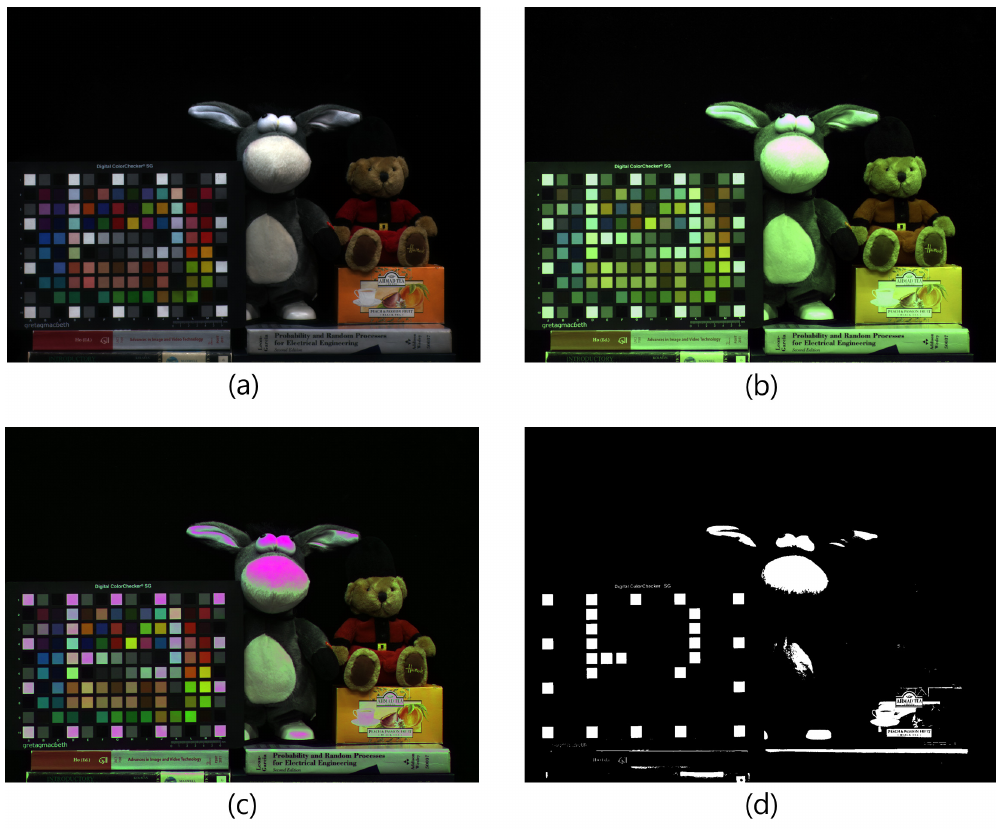
Figure 5. Color correction error due to the early saturation problem (fluorescent lamp): ( a ) Conventional Bayer CFA image; ( b ) Image obtained by RWB CFA sensor with saturated W pixels; ( c ) Color-corrected image of (b); and ( d ) Saturated area in W